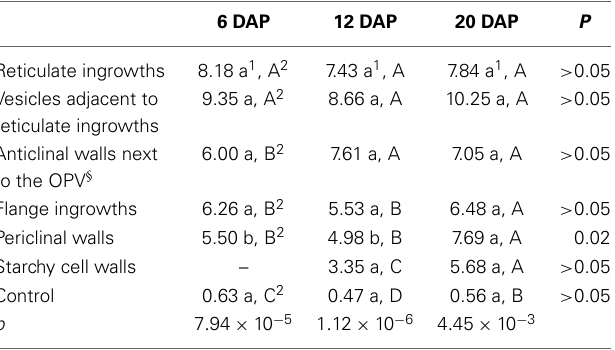
Table 1 | The average percentage concentration of elemental Mn in transfer cells and starchy cells at 6, 12, and 20 DAP, determined by